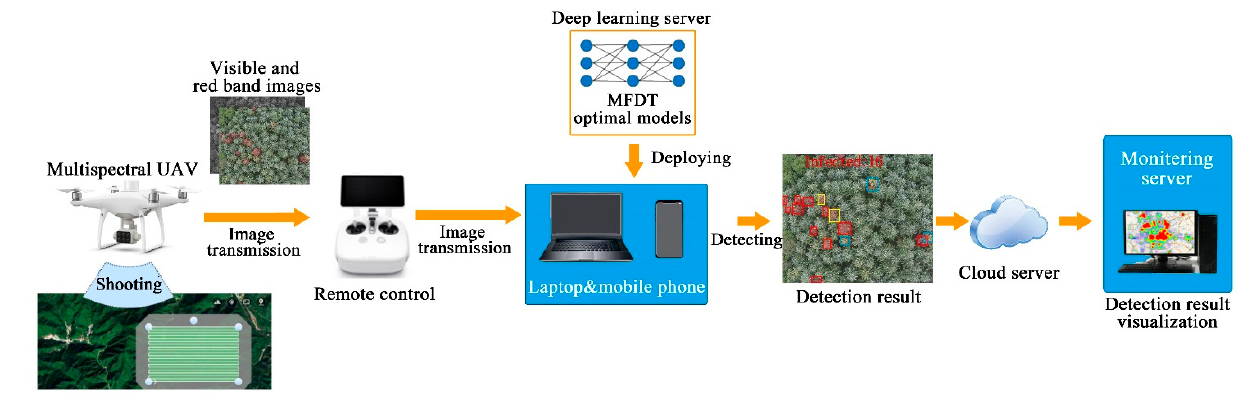
Figure 13. The UAV monitoring process with MFTD.